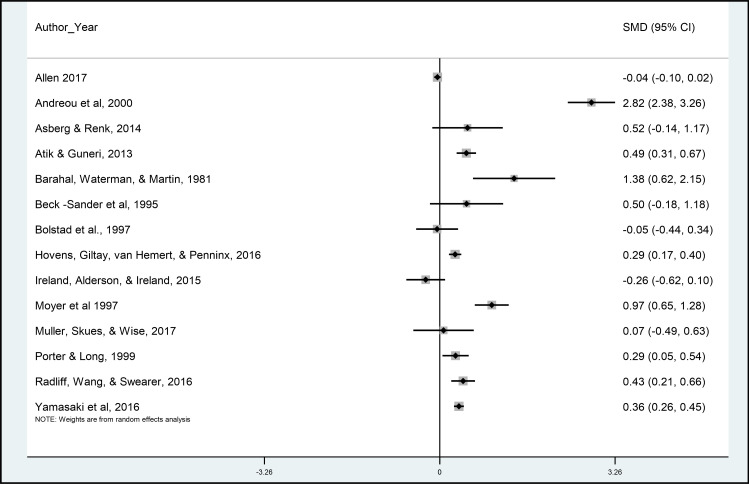
Meta-analysis forest plot of childhood trauma and Standardised Mean Difference (SMD) in locus of control.